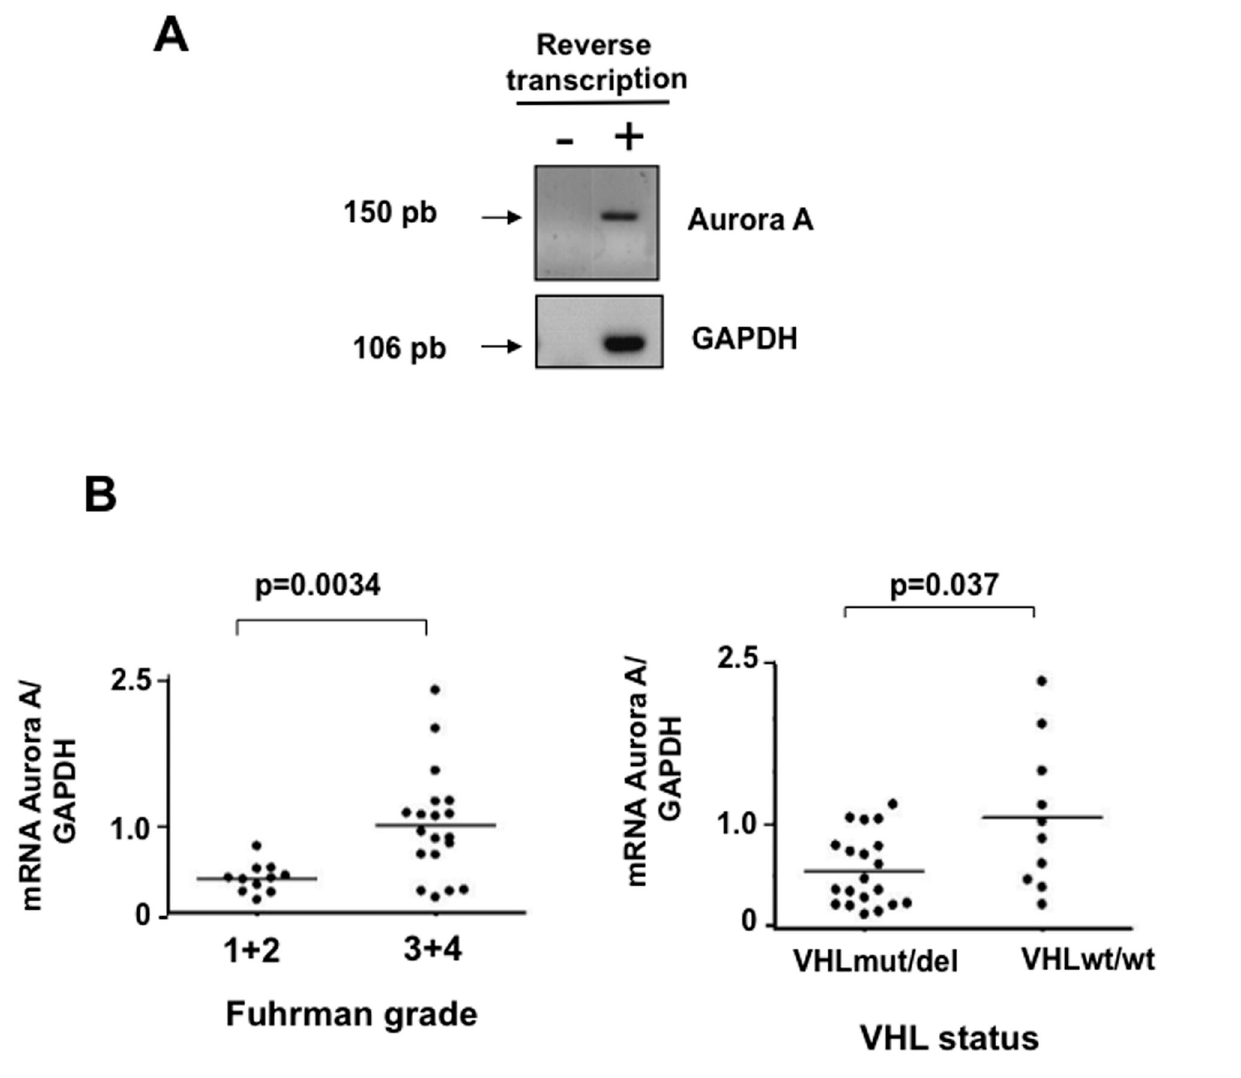
Figure 1. Relative expression of the Aurora-A kinase in ccRCC and matching healthy tissue samples. A- Expression of Aurora-A in tumours and neighbouring healthy tissues. Total RNAs extracted from tumour tissues were reverse transcribed and Aurora-A expression was then analysed by PCR using specific Aurora-A primers that produced an amplicon of 150 bp. Expression values were normalized to GAPDH levels. B -Aurora-A transcript levels are correlated with the tumour Fuhrman grade and VHL status. Quantitative RT-PCR data were normalized to GAPDH and then their distribution according to the tumour grade and VHL status was analysed using the Mann-Whitney test. The Aurora-A transcription level of each tumour is symbolized by a dot and the median by a horizontal line. doi: 10.1371/journal.pone.0067071.g001 includes Ser72 (…SREP S *QVIF…) matched the putative [γ- 32 P] ATP (Figure 5). 32 P was incorporated in VHL in Aurora-A consensus phosphorylation site [(K/R) xx(S/T)] the presence of Aurora-A (Figure 5: lane 1) and mass (Figure 5). Mutation of Ser72 into alanine (VHL SA72) spectrometry analysis of 32 P-VHL allowed identifying greatly diminished phosphorylation of pVHL by Aurora- Ser72 as the most phosphorylated amino acid. Three A (Figure 5, lane 2). different productions and purifications of pVHL and Aurora-A proteins were done and used in two independent kinase assays before identifying the phosphorylation site. Accordingly, the sequence which